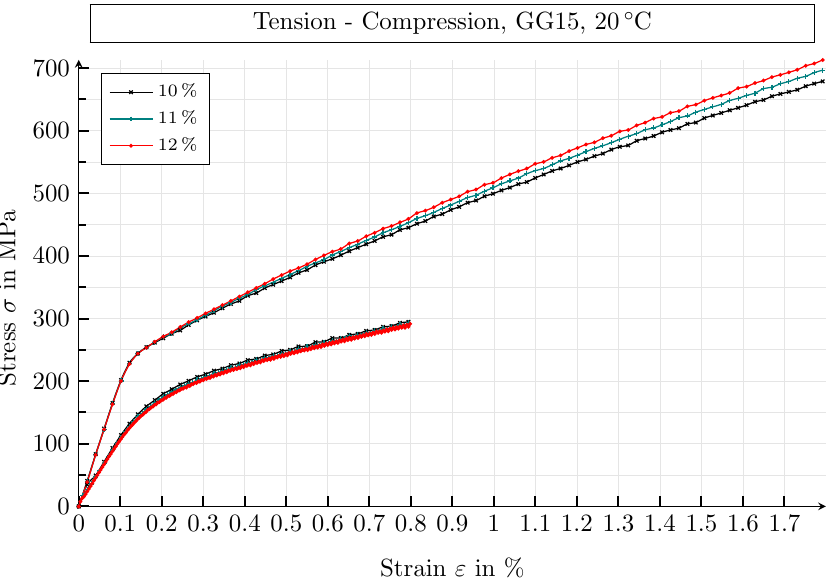
Figure 20. Stress–strain diagrams of GJL-150 graphite morphologies under tensile and compressive load, with a variable graphite volume fraction at room temperature. For a clearer representation, the stress–strain curves of the compressive simulations are given by positive